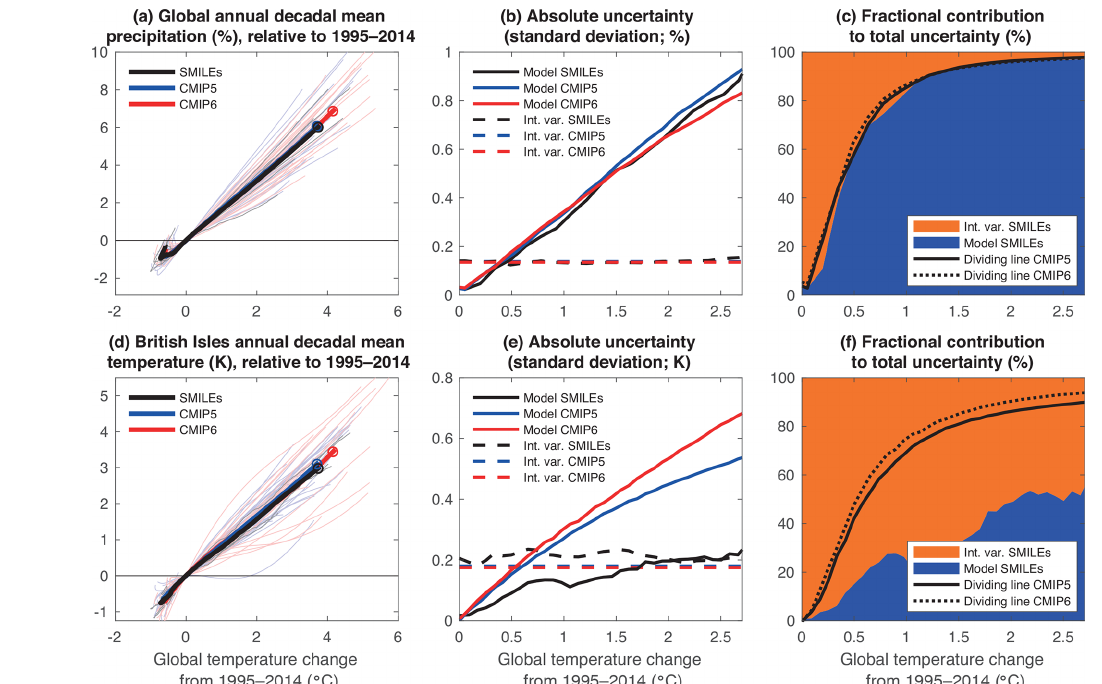
Figure 8. (a) Decadal means of global mean precipitation change as a function of global mean temperature change. Thin lines are forced response estimates from individual models, and thick lines are multimodel means for SMILEs, CMIP5 and CMIP6. The last decade of each multimodel mean is marked with a circle. (b) Uncertainty in global mean precipitation changes from model differences and internal variability in SMILEs, CMIP5 and CMIP6 as a function of global mean temperature. (c) Fractional contribution of global mean precipitation changes from model uncertainty and internal variability to total uncertainty as a function of global mean temperature. The colors indicate the fractional uncertainties from internal variability and model uncertainty in SMILEs, while the solid and dotted lines indicate where the dividing line between these two sources of uncertainty (i.e., between orange and blue colors) would lie for CMIP5 and CMIP6. (d–f) Same as (a) – (c) but for British Isles